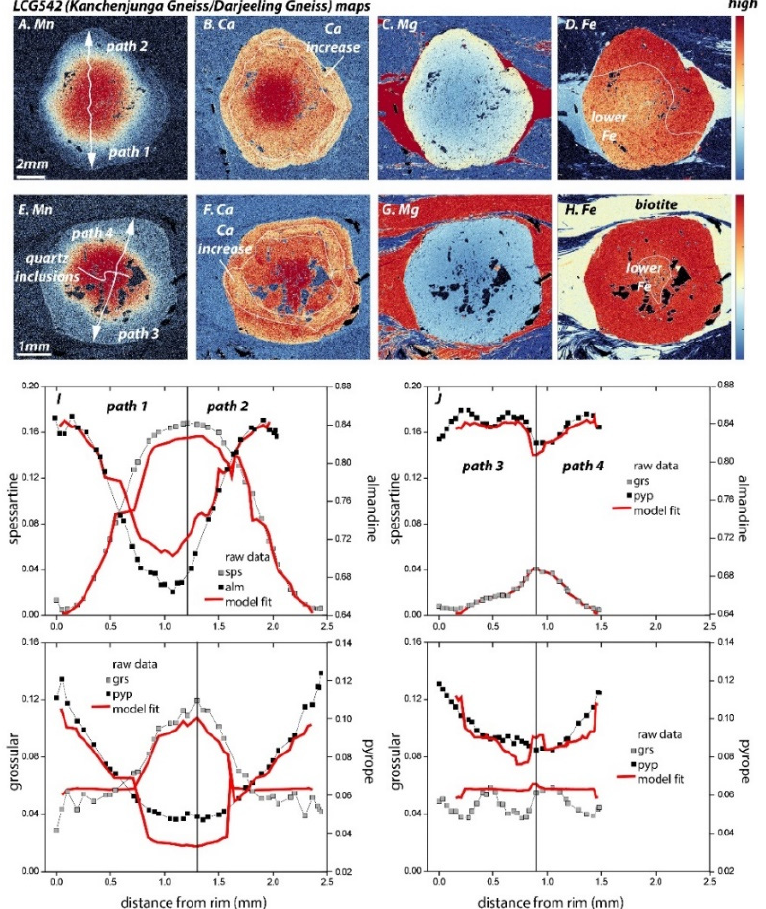
Figure 12. X-ray element maps of sample LCG542 (Kanchenjunga/Darjeeling Gneiss) in ( A ) and ( E ) Mn, ( B ) and ( F ) Ca, ( C ) and ( G ) Mg, and ( D ) and ( H ) Fe. Garnet compositions in spessartine (sps) and almandine (alm) ( upper panel I , J ) and grossular (grs) and pyrope (pyp) ( lower panels I , J ) were taken across the rim to rim transects identified in panels ( A , E ). The red lines in panels ( I , J ) show the prediction of the high-resolution P-T paths generated for this sample.